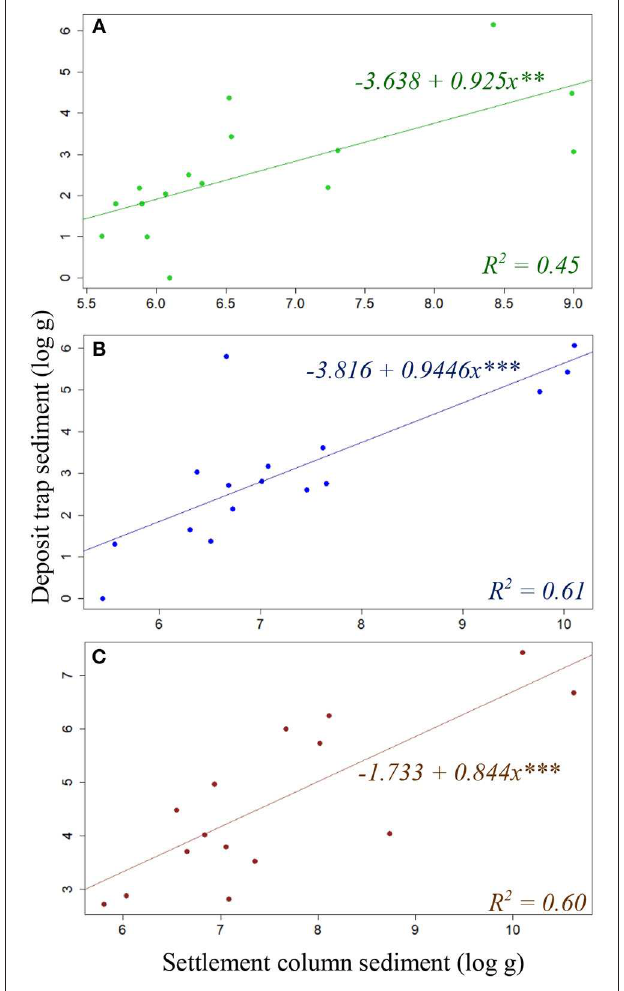
FIGURE 4 | Sediment settlement and deposit dry weights across seasons for each area, corrected to 1 m 2 equivalent, each point is averaged value of single sampling occasion. (A) Natural (green), (B) Restored (blue), (C) Mudflat (brown). Displaying linear regression trend line and equations for each area, significance codes: 0 “***”, 0.001 “**”.